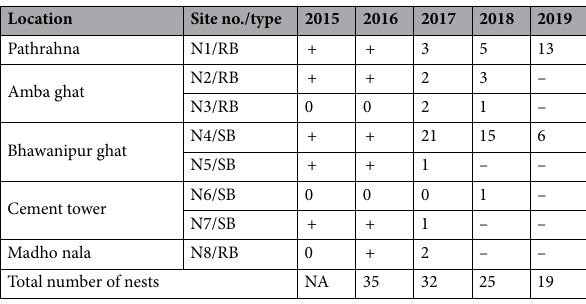
Table 2. Nest site usage in Katerniaghat Wildlife Sanctuary by gharials, 2015–2019. RB river bank, SB mid river sand bar, 0 = vacant site, + = nesting (no counts), – = no subsequent nesting. NA not